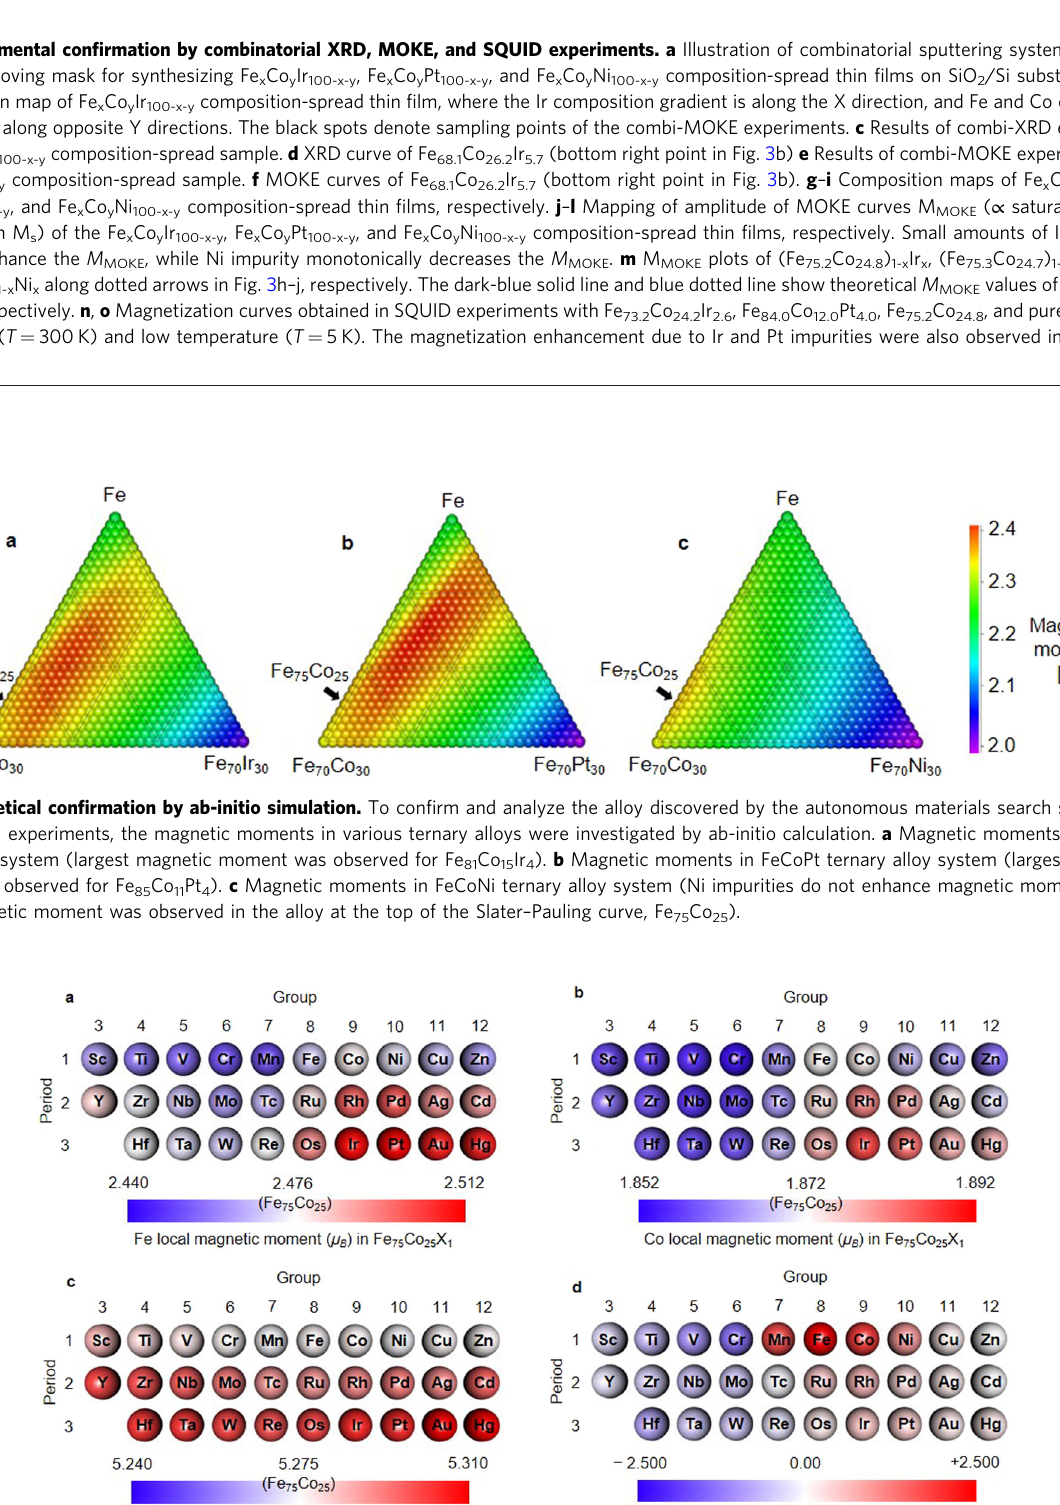
COMMUNICATIONS MATERIALS| (2021) 2:31